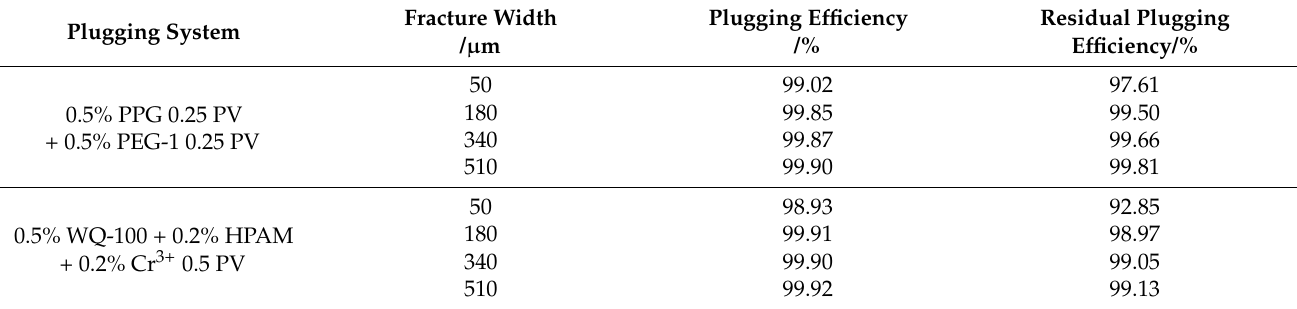
Table 7. Plugging efficiency of multiple pre-crosslinking gel particles on the fractured reservoir.